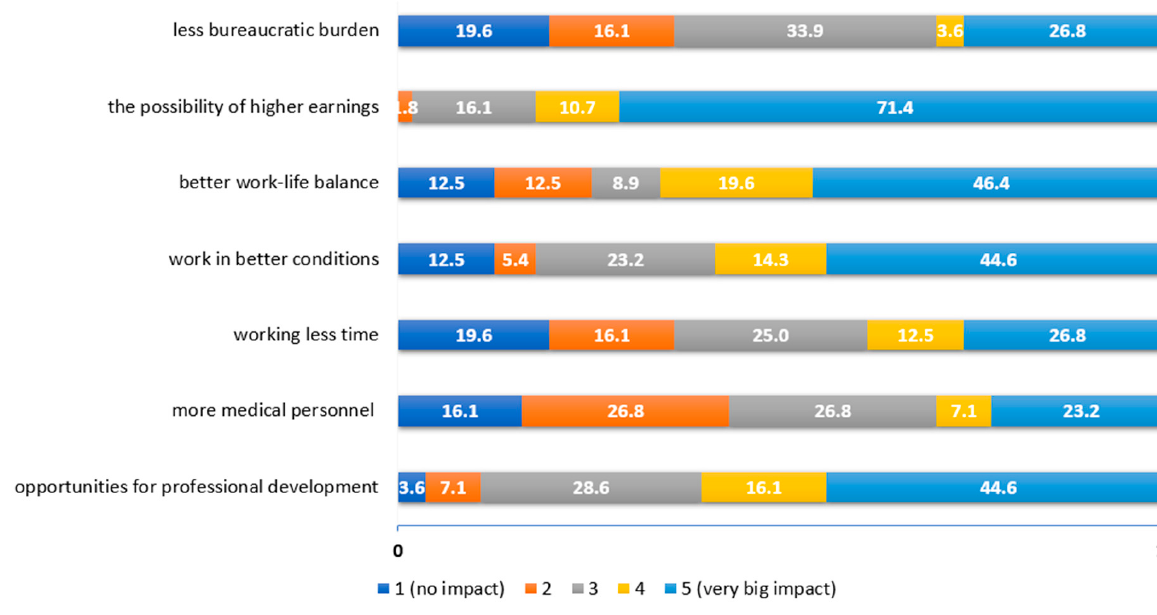
Figure 5. Assessment of the influence of push factors according to practicing physiotherapists. 3.3. Destination Countries for Migration The most frequently declared countries of potential migration of physiotherapy stu- dents were Germany (32.1%), Norway (26.4%), France (24.5%), Switzerland (24.5%) and the United Kingdom (24.5%). In turn, the most common destination countries indicated by practicing physiotherapists were: Germany (42.9%), Switzerland (28.6%), Norway (25.0%), France (23.2%) and the United Kingdom (17.9%). 3.4. Barriers to Emigration The majority of physiotherapy students (62.7%) indicated “differences in education” as a migration barrier. Physiotherapy students also indicated leaving family (60.8%) and language barrier (58.8%) as significant barriers to migration. Almost 55.4% of practicing